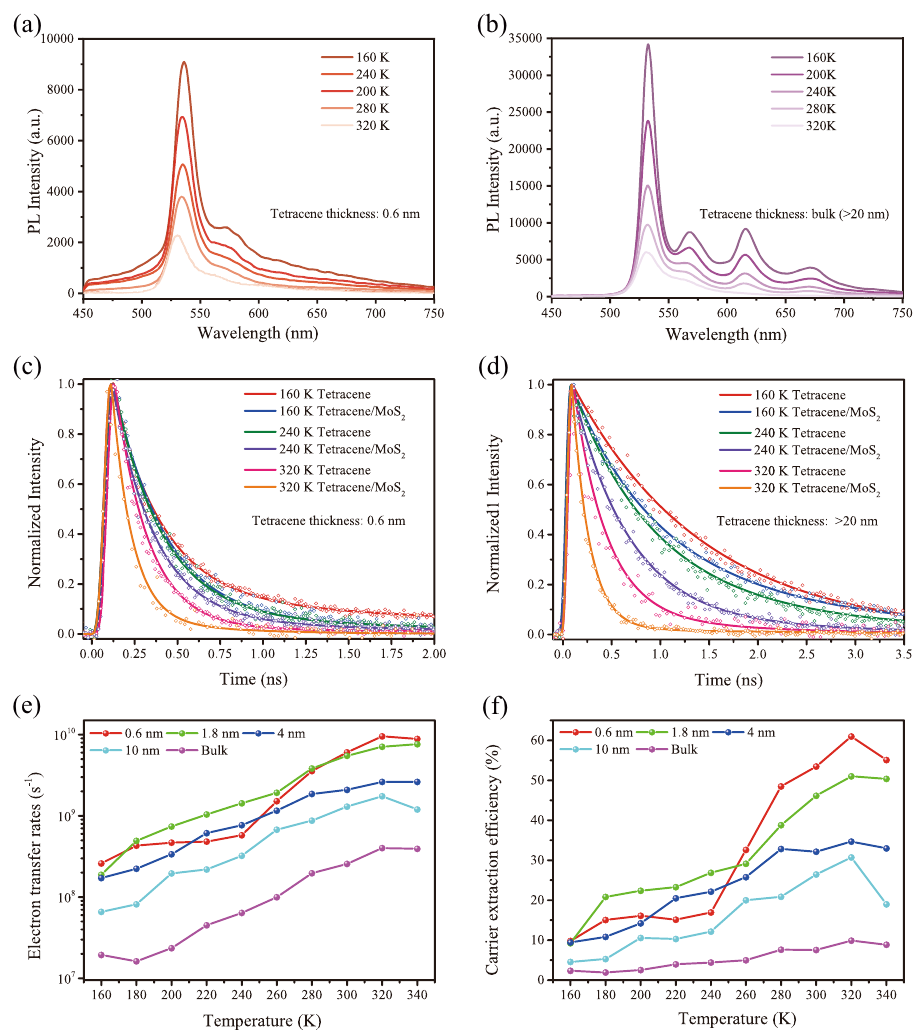
Fig. 4 Temperature-dependent interlayer carrier dynamic characteristics. a Steady-state PL spectra of 2D tetracene layer from 160 to 320 K. b Steady-state PL spectra of 3D tetracene layer from 160 to 320 K. c The results of the time-resolved spectra of tetracene in isolated 1 L tetracene and 2D tetracene/MoS 2 structures at 160 K, 240 K and 320 K, respectively. d The results of the time-resolved spectra of tetracene in isolated bulk tetracene and 3D tetracene/MoS 2 structures at 160 K, 240 K and 320 K, respectively. e The results of the temperature-dependent electron transfer rates with different organic layer thicknesses. f The results of the temperature-dependent carrier extraction ef fi ciency with different organic layer